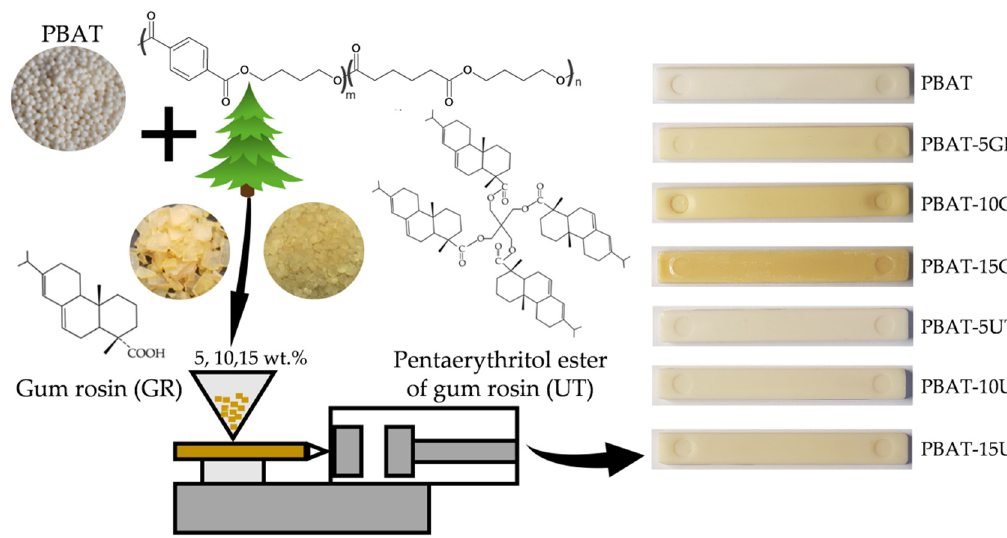
Scheme 1. Schematic representation of the production of PBAT-resin injection moulded